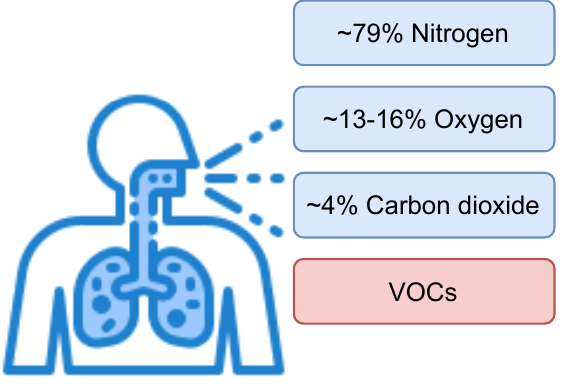
Figure 1. General composition of humans’ exhaled breath. Table 1. Potential disease biomarkers in the breath.